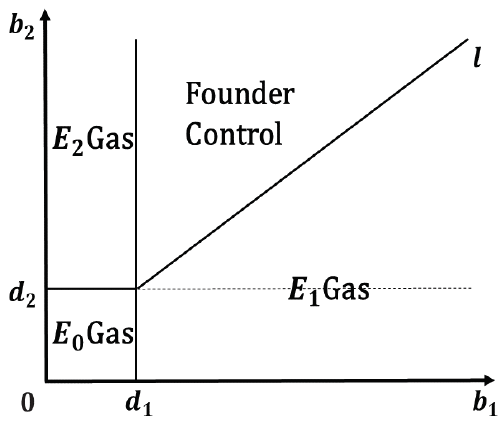
Figure 1. Stability regions of the states of system (1) in ( b 1 , b 2 ) -space. The diagonal line l satisfying b 1 > d 1 , b 2 > d 2 and 1